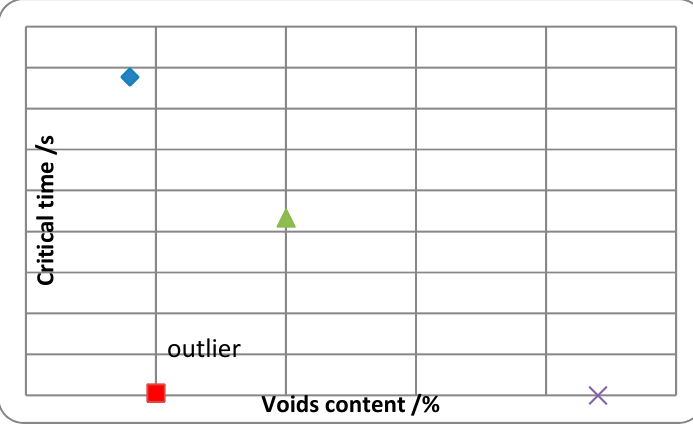
Figure 15. Relationship between the critical time and voids content.